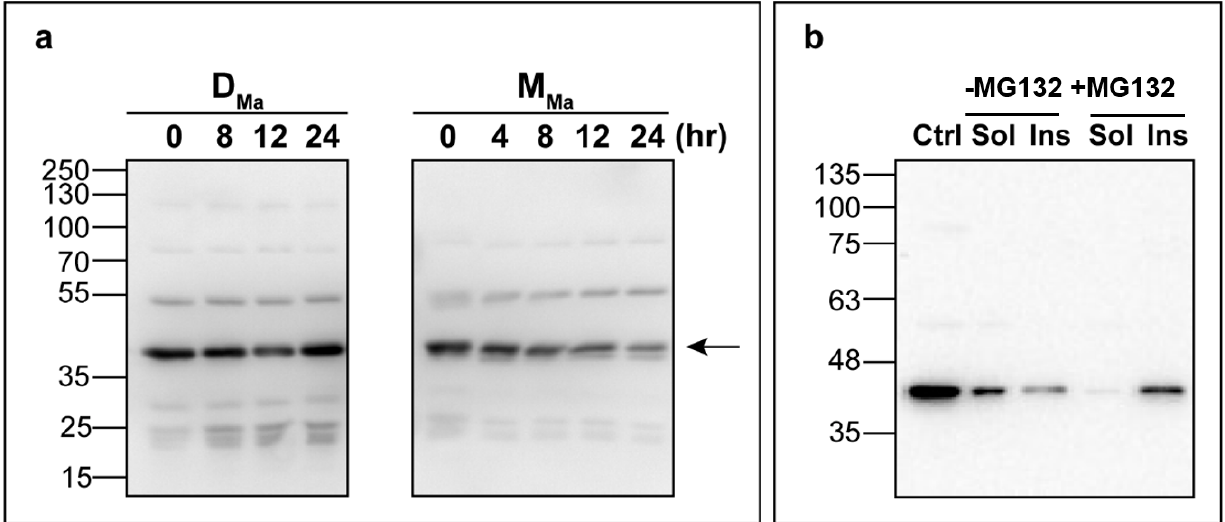
Figure 2. Intracellular stability of monomeric and dimeric AGT. ( a ) Measurement of the half-life of D Ma and M Ma by a cycloheximide chase assay. CHO-GO cells expressing either D Ma or M Ma were grown in the presence of cycloheximide (10 µg/mL); at different times cells were harvested and lysed. Five micrograms of cell lysates were analyzed by Western blot with an anti-AGT antibody from rabbit. The arrow indicates the band relative to AGT ( b ) Effect of the treatment with MG132 on the AGT expression levels of CHO-GO expressing M Ma . CHO-GO cells expressing M Ma were treated for 24 h with 10 µM MG132 and 10 µg of lysate were analyzed by Western blot for the amount of AGT in the soluble (Sol) and insoluble (Ins) fraction using an antibody against AGT from rabbit. Ctrl represents the positive control of CHO-GO cells expressing D Ma. Images shown are representative of at least three independent experiments.